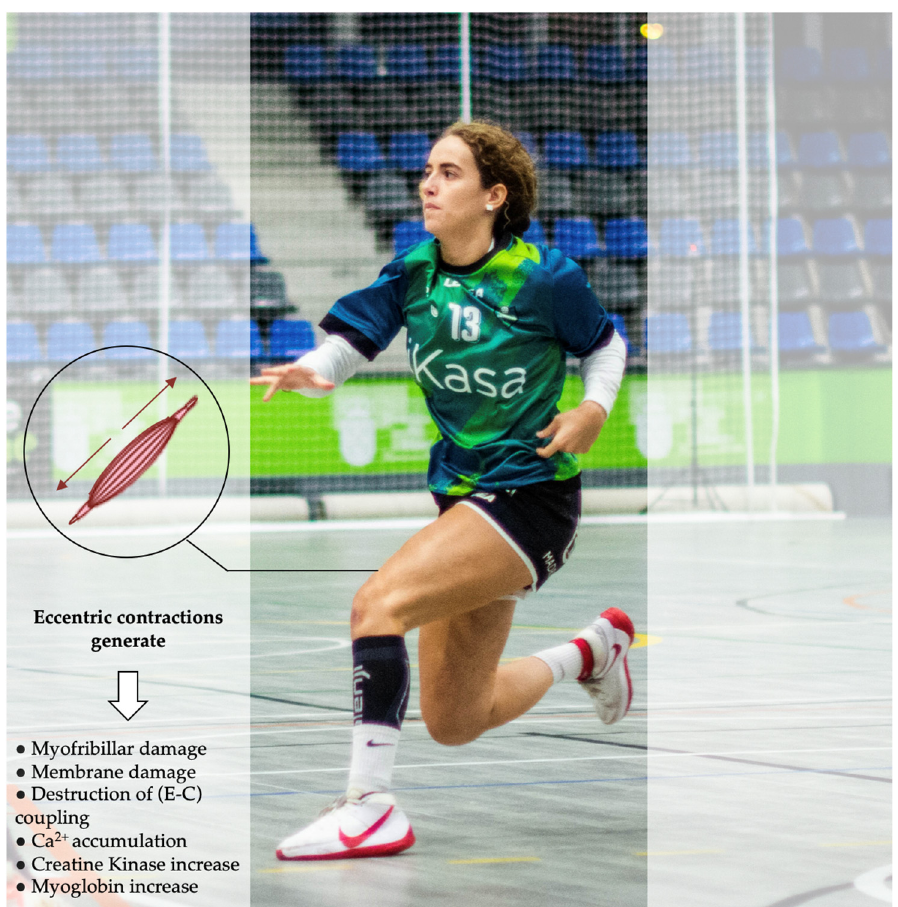
Figure 8. Physiological responses of repeated high-intensity decelerations.